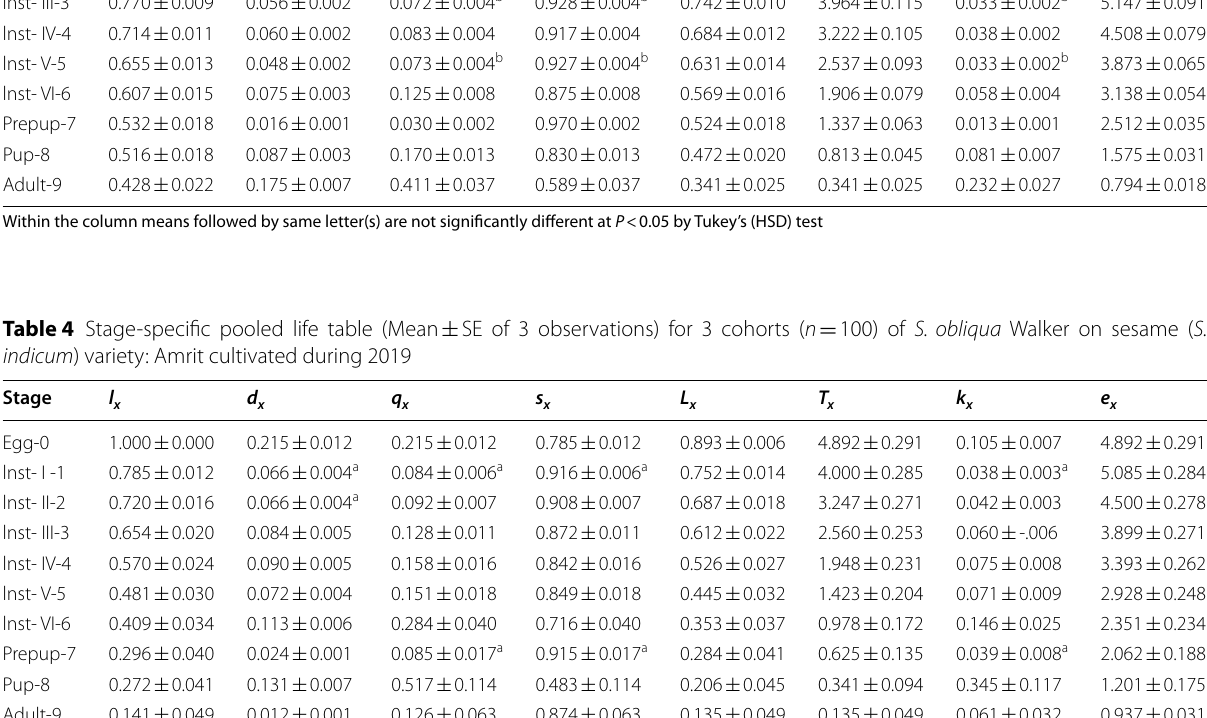
Within the column means followed by same letter(s) are not significantly different at P < 0.05 by Tukey’s (HSD) test